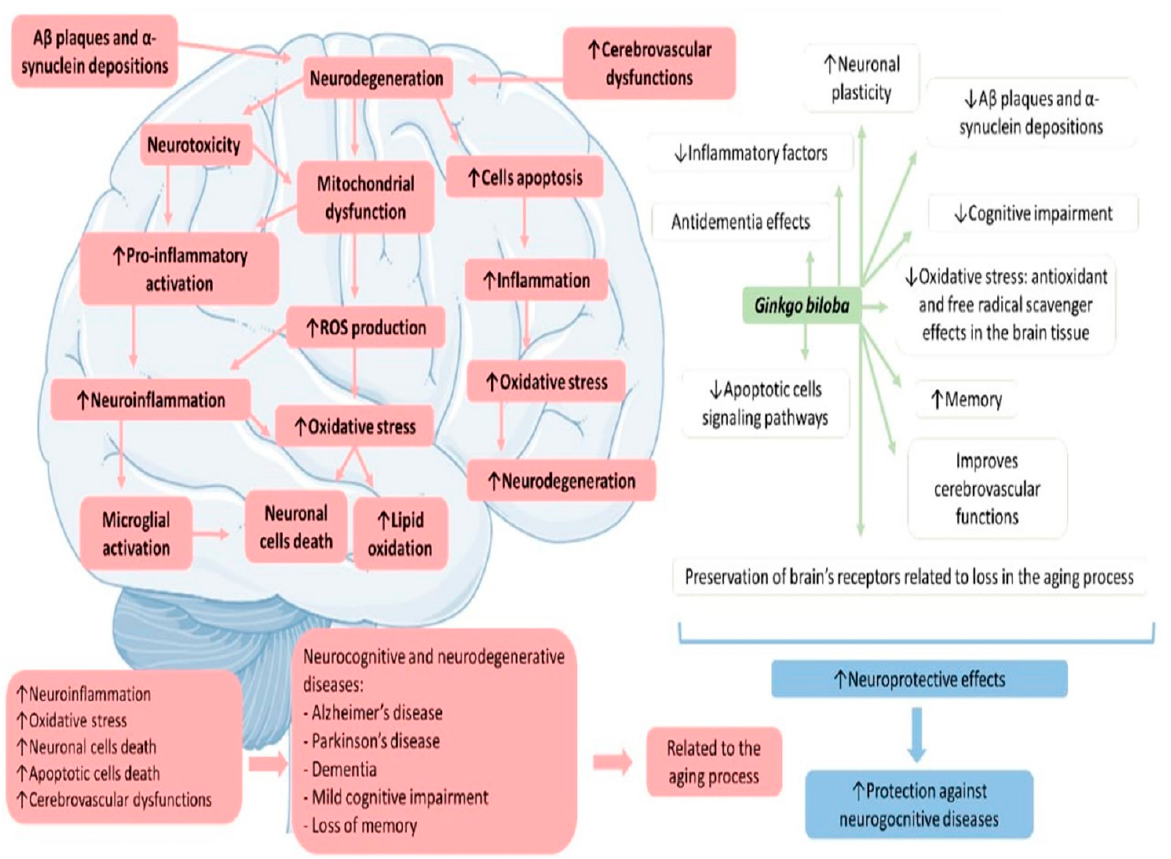
Figure 3. Ginkgo biloba : general effects against neurodegenerative diseases. ↑ —increase; ↓ —decrease; A β —beta amyloid.